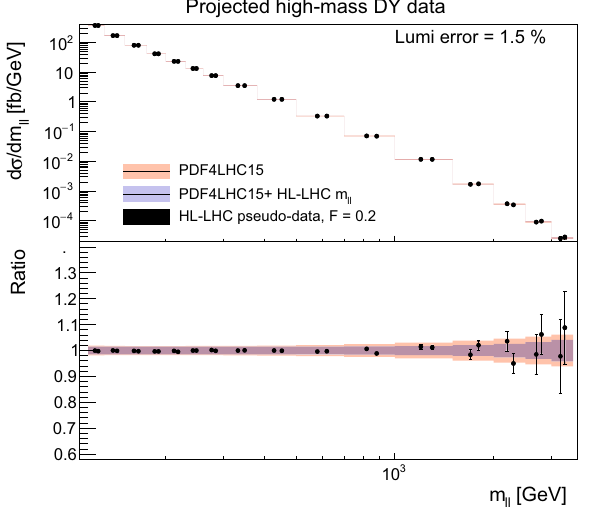
Fig. 5 Comparison between the HL–LHC pseudo–data and the the- oretical predictions for high–mass (left) and forward (right) Drell– Yan production. The theory calculations are shown both before (PDF4LHC15) and after profiling. Luminosity uncertainties are not